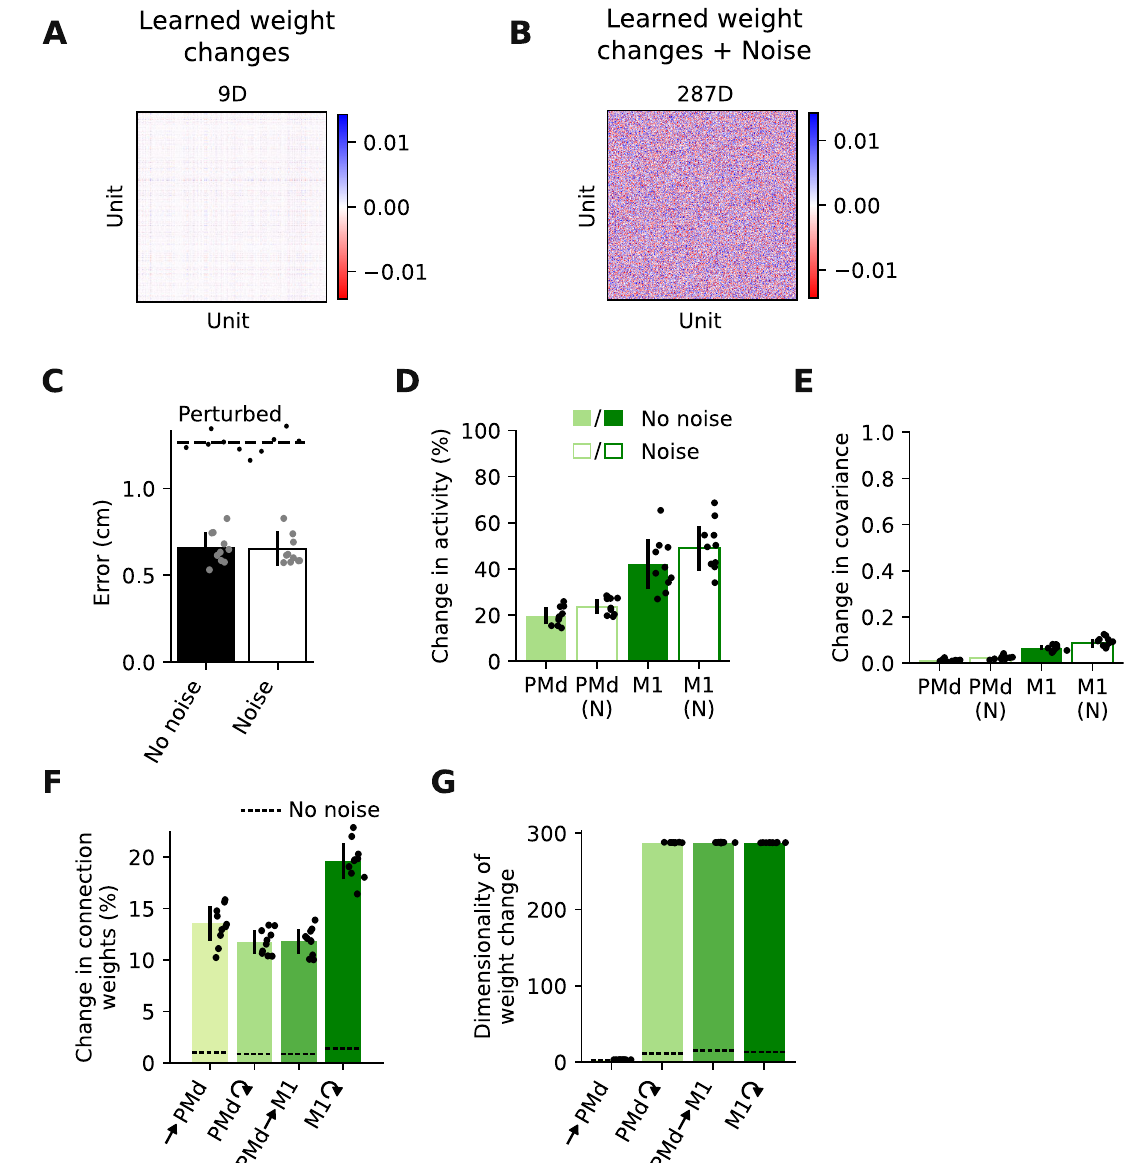
Fig. 6 | Low-dimensional connectivity changes are highly robust to noise. A Example changes in M1 connection weights following VR adaptation. Same data as in Fig. 5B. B Same connection weight changes as in A , but with random con- nectivity changes added. Note the dramatic increase in the dimensionality of the connection weight changes. C Root mean squared error between target and pro- duced hand trajectories following adaptation in models with and without random weight changes; bars and error bars, mean and s.d. ( n =10 network initializations),